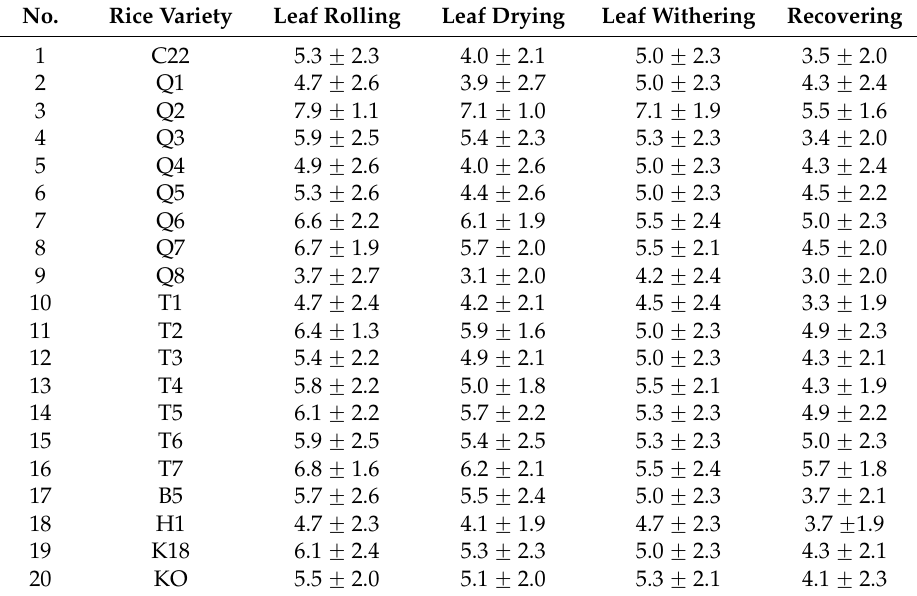
Table 3. Resistant categories and levels of rice under water deficiency stress. No. Rice Variety Leaf Rolling Leaf Drying Leaf